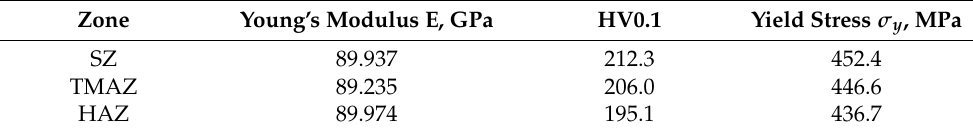
Table 3. Young’s modulus and yield stress in the principal zones of RFSSW joint.